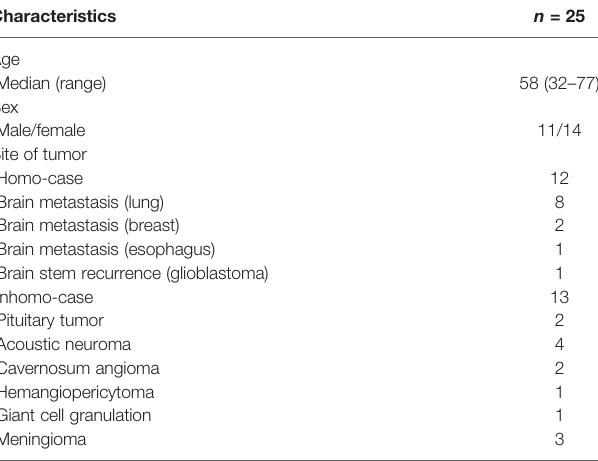
TABLE 1 | Patient details in this